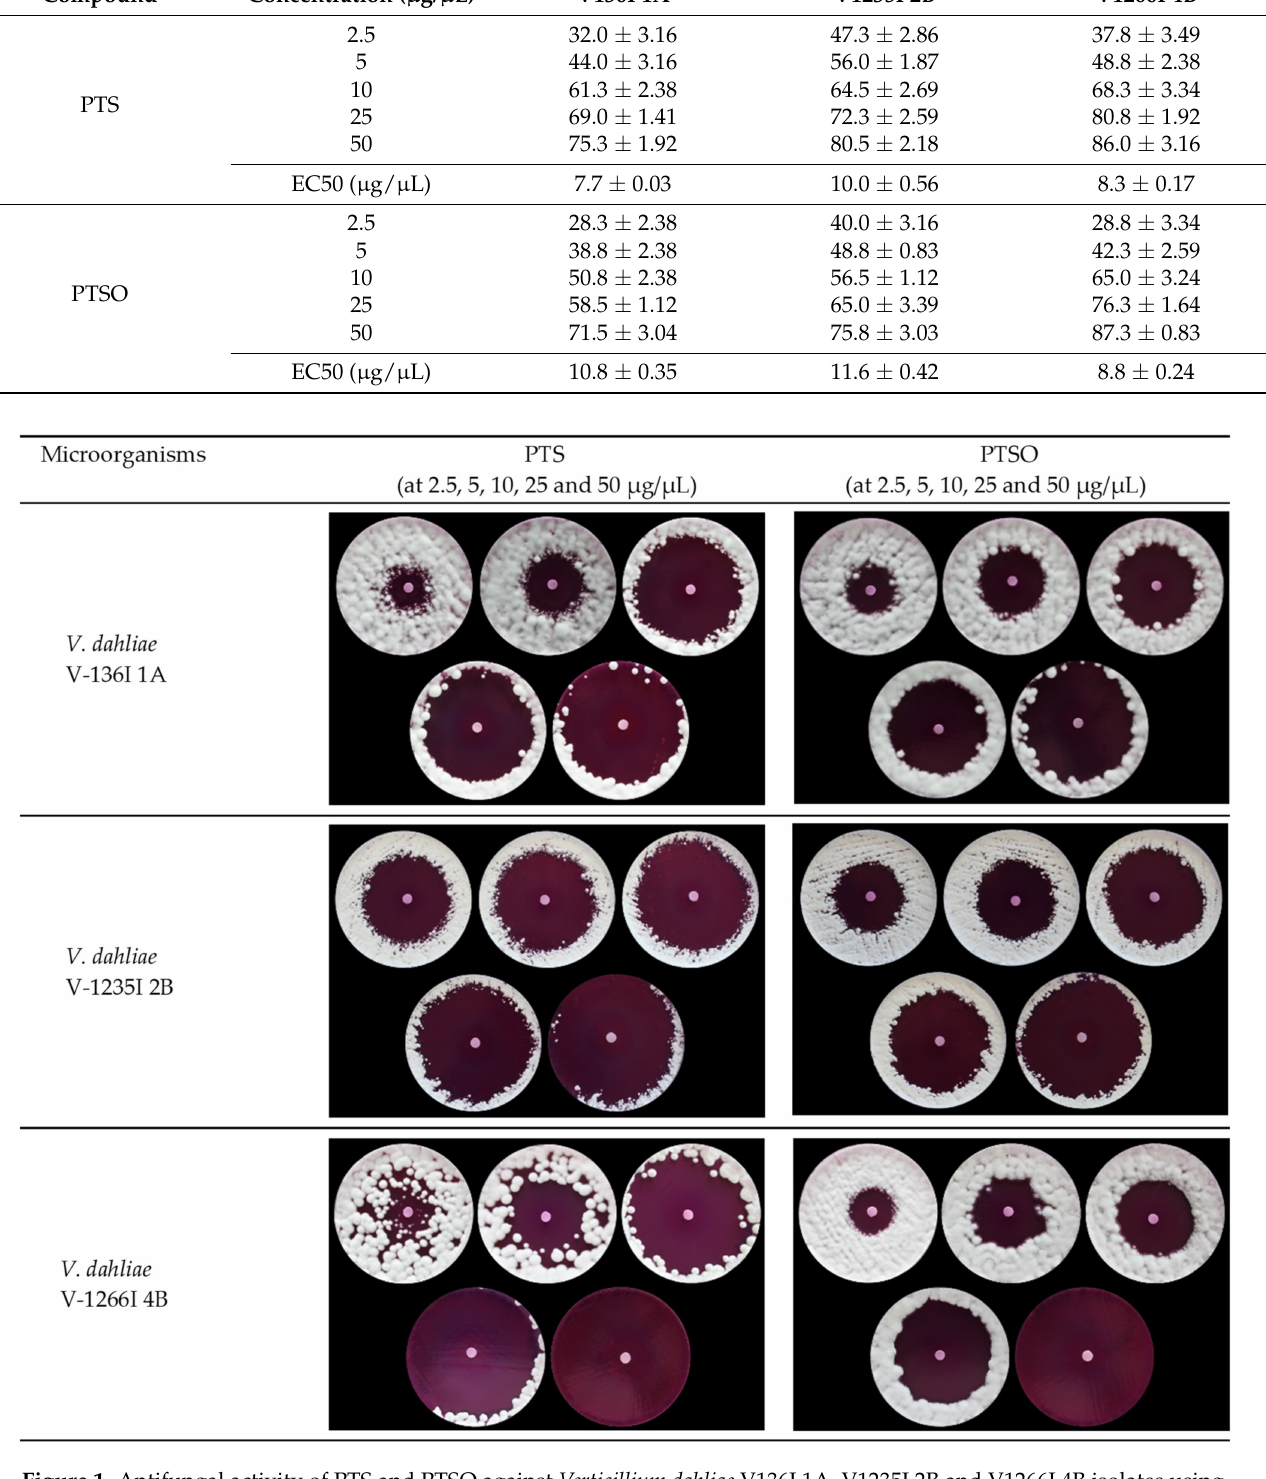
Figure 1. Antifungal activity of PTS and PTSO against Verticillium dahliae V136I 1A, V1235I 2B and V1266I 4B isolates using the disk-diffusion method. The image shows inhibition zones at doses of 2.5, 5, 10, 25 and 50 µ g/ µ L from left to right and from top to